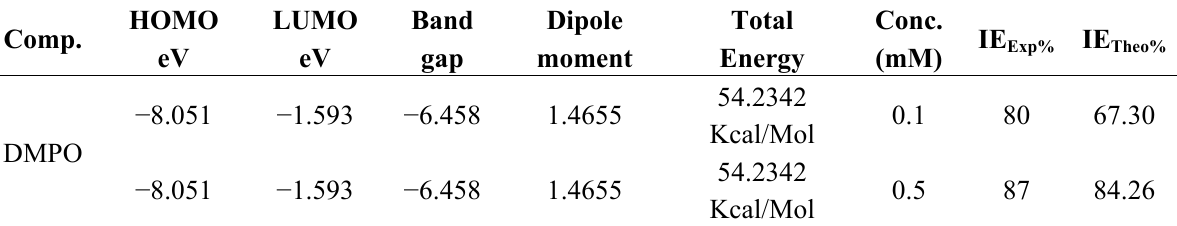
Table 4. Molecular properties of the optimized synthesized